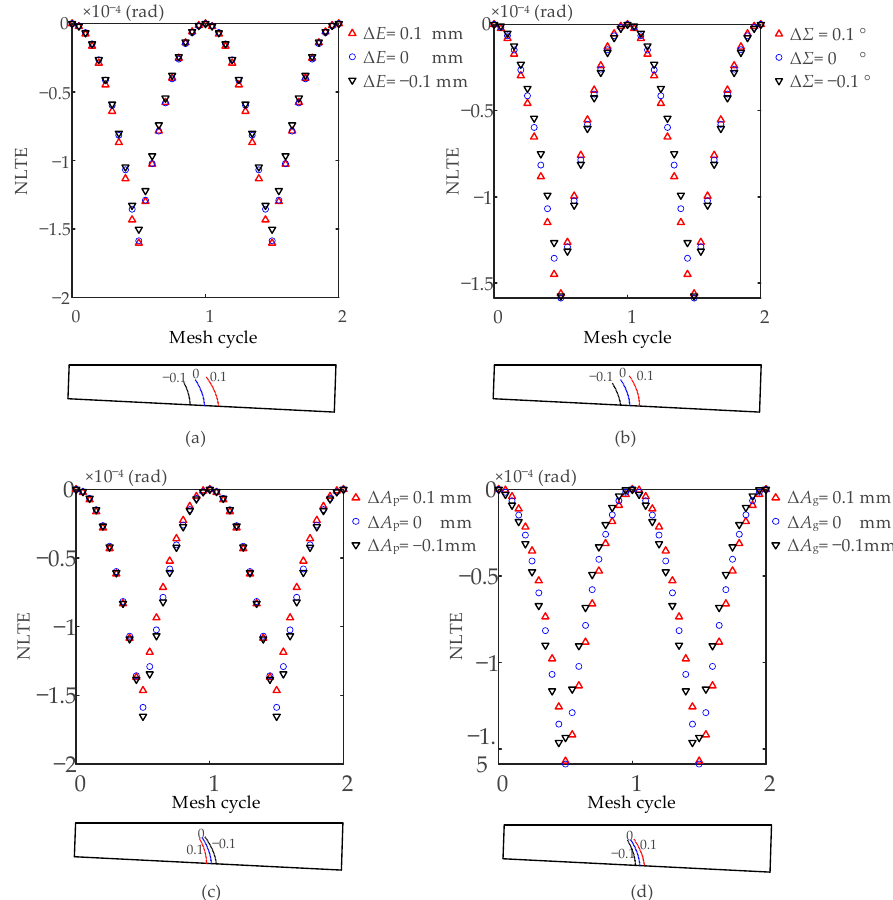
Figure 3. Contact trajectories and NLTEs variation due to the assembly errors: (a) Δ E ; (b) ΔΣ ; (c) Δ A g ; (d) Δ A p .